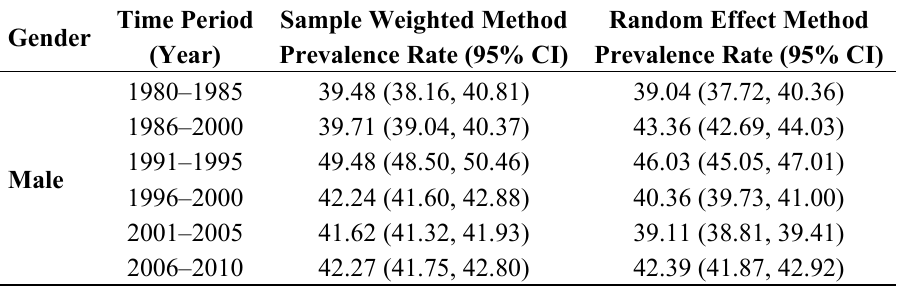
Table 1. Comparison of the estimated prevalence rates (95% CI) of lifetime smoking among adolescents in China using two different